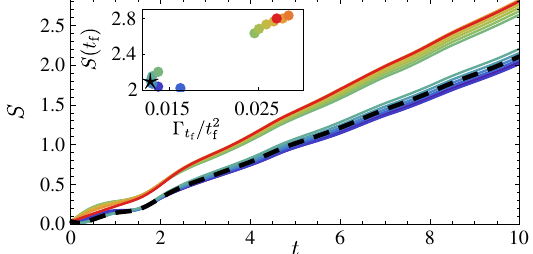
FIG. 16. Entanglement growth in the deformed PXP model [Eq. (D1)] strongly depends on initial conditions. All initial conditions are chosen to have the same energy density h H i =L ¼ 0 and the same entanglement entropy. The light blue line corre- sponds to the periodic trajectory. The inset shows the correlation between the value of entanglement at late time and quantum 10 =t 2 leakage Γ , t t f f ¼ f